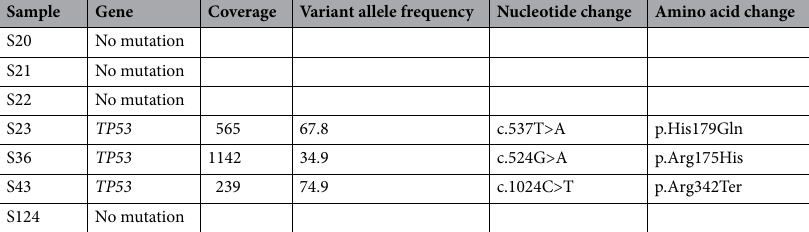
Table 1. List of somatic mutations in the 55 gastric cancers with current H. pylori infection. a Activated oncogene mutation. b These mutations did not exist on the same